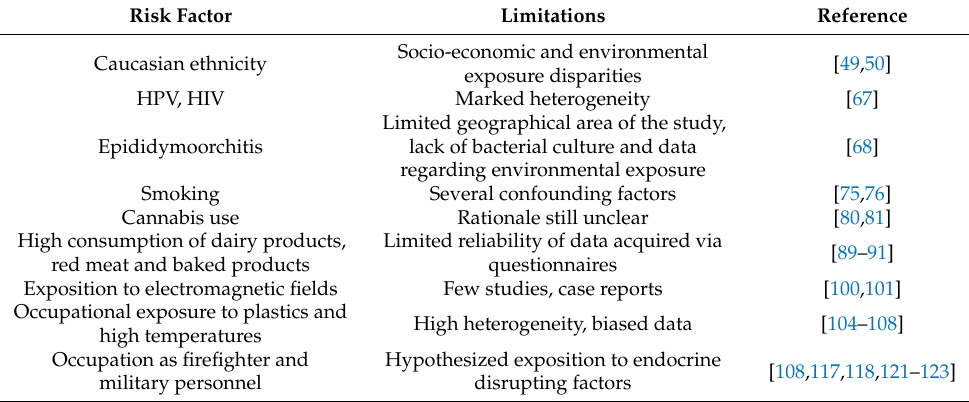
Table 2. Probable risk factors associated with testicular